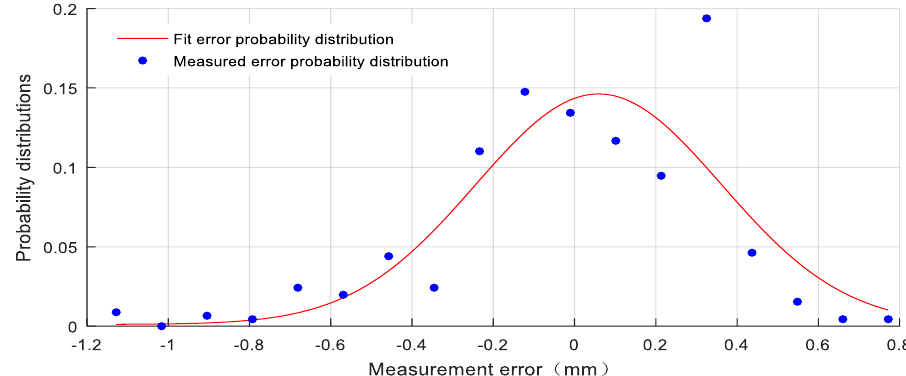
Figure 9. Fitting of the measurement error distribution (a = 0.11, μ = 0.0592, σ = 0.6052).